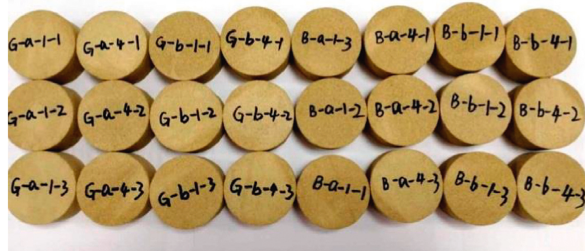
Figure 1: Cold region distribution in Table 1: Physical and mechanical properties of yellow sandstone